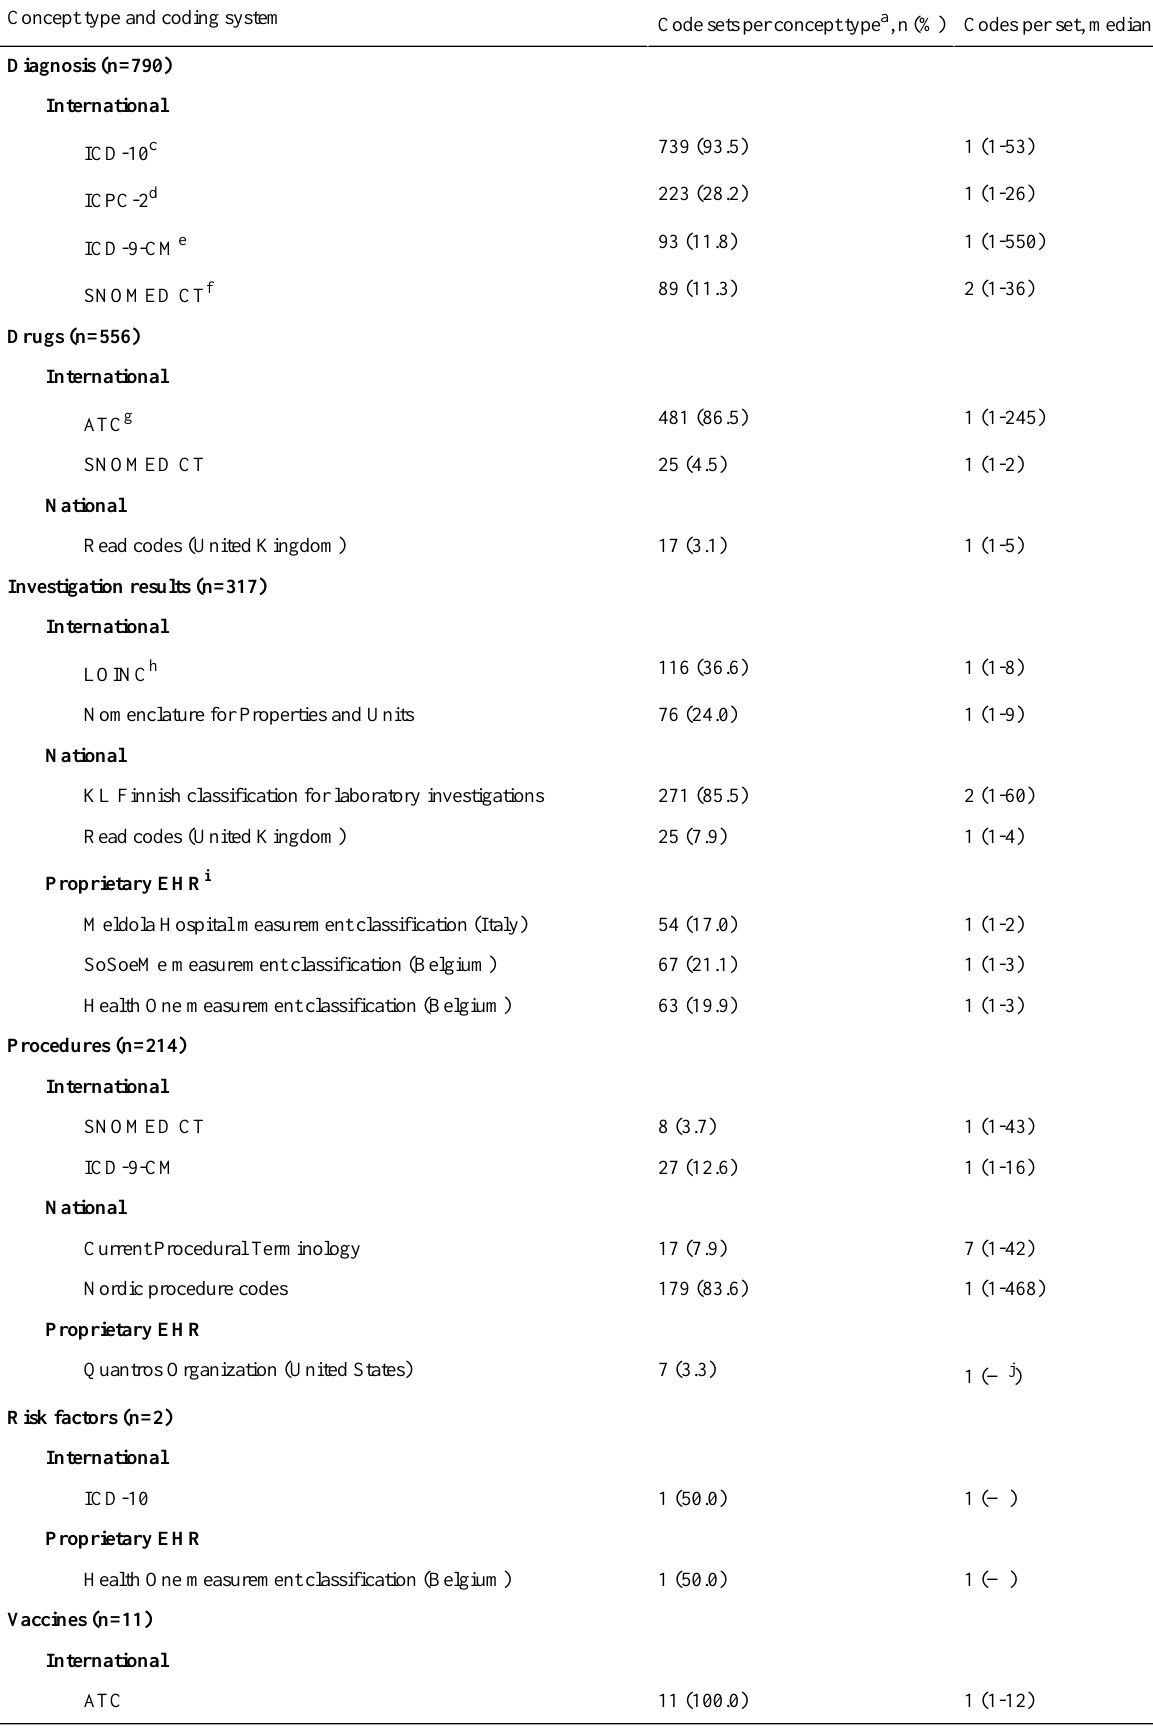
Table 3. Code sets defined in the EBMeDS